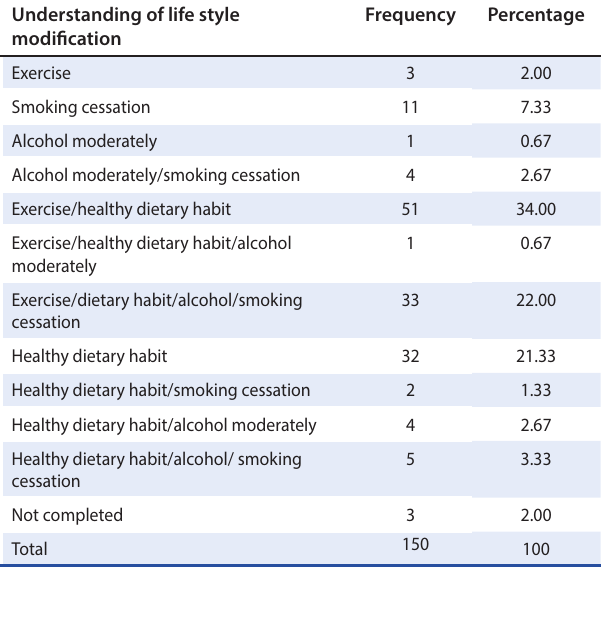
Table 2: Understanding of lifestyle modification